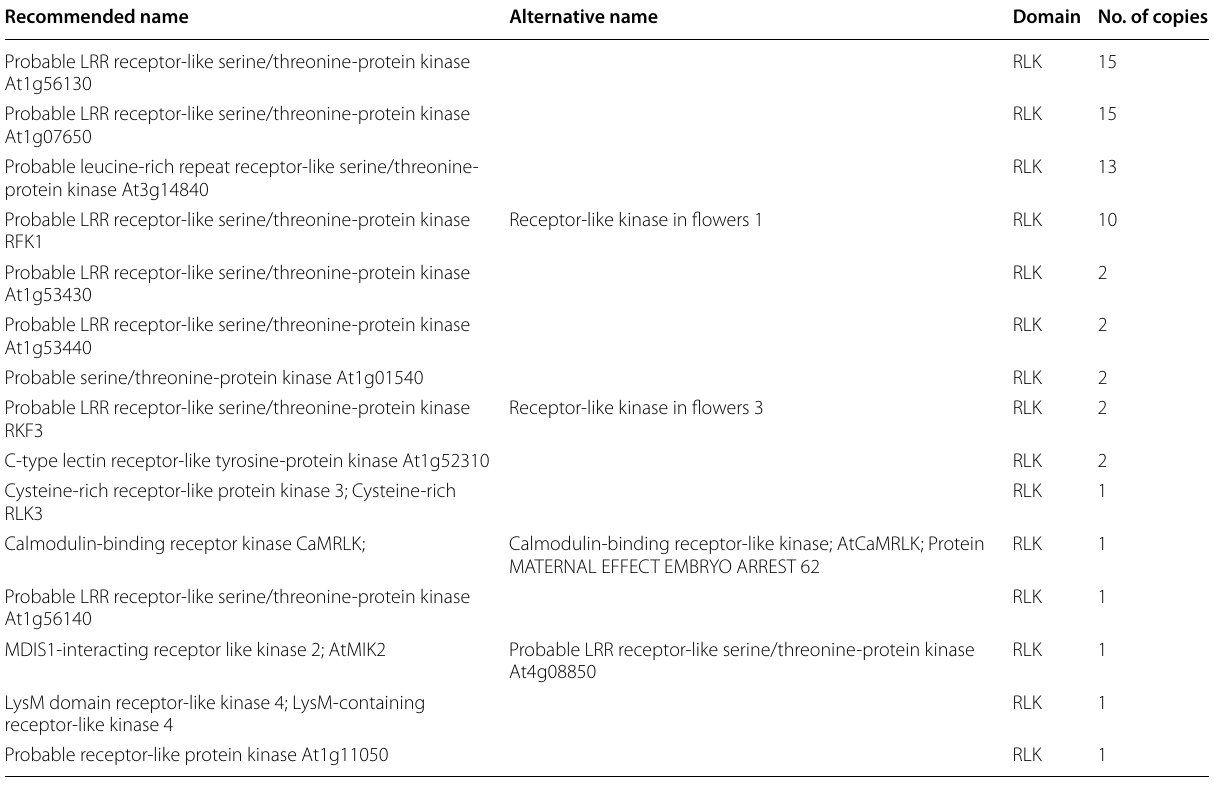
Table 3 Durian RGAs with homology to proteins in UniProtKB/SwissProt database with “response to insect” GO